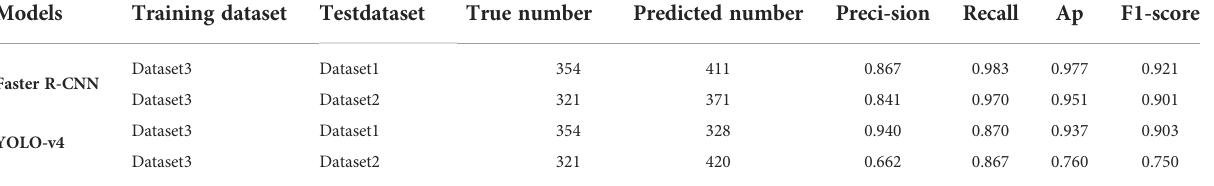
TABLE 6 The performance in the generalizability test using different models.